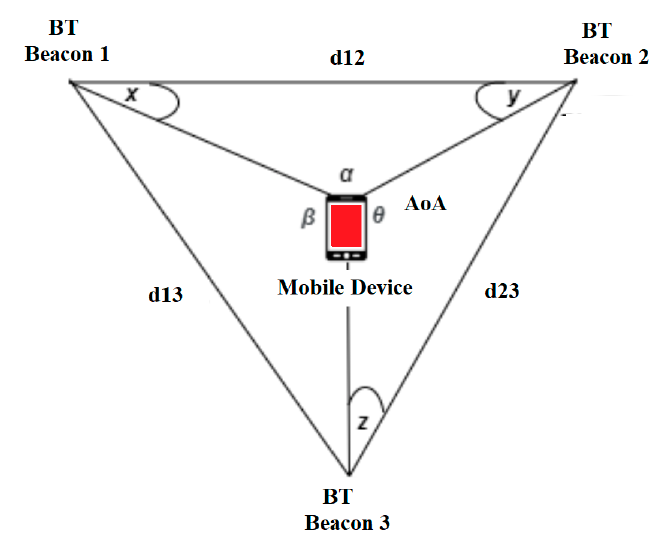
Figure 3. Triangulation location estimation using AoA, distance and time information.